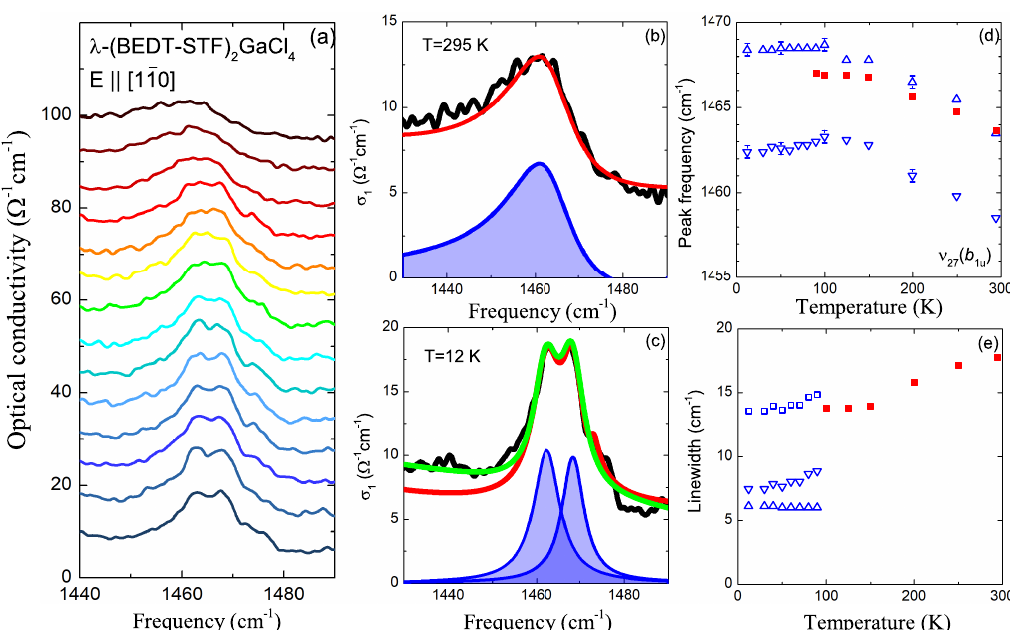
Figure 8. ( a ) Temperature evolution of the optical conductivity of λ -(BEDT-STF) 2 GaCl 4 in the region of the molecular vibration ν 27 (b 1 u ). The data are shifted with respect to each other by a constant offset for clarity reasons. ( b , c ) Fits of the vibrational mode at T = 295 and 12 K. The experimental data are shown in black, the red lines correspond to the overall fit, and the blue lines are separate contributions to the mode. From the two-state jump model [Equation (7)], we obtain the green line. ( d , e ) Temperature dependence of the resonance frequency and linewidth of the charge-sensitive mode ν 27 (b 1 u ). While the red squares correspond to the fit by a single contribution for T ≥ 90 K , the blue symbols represent the two-mode description, where triangles and rotated triangles are related to different Lorentzians; the open blue squares in panel ( e ) correspond to the sum of both, demonstrating that the overall width does not